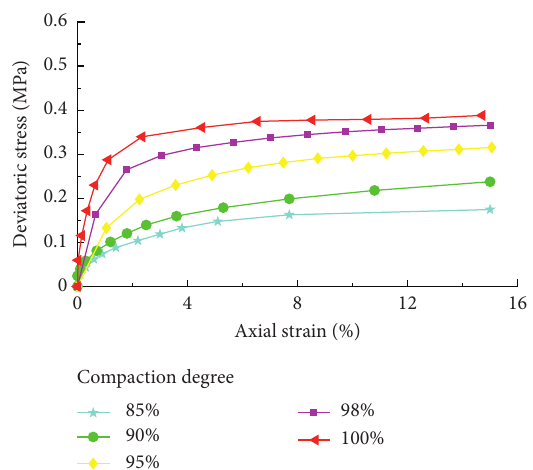
Figure 2: Effect of compaction degree on performance of natural soil (confining pressure � 0.1MPa; water content � 8.5%).